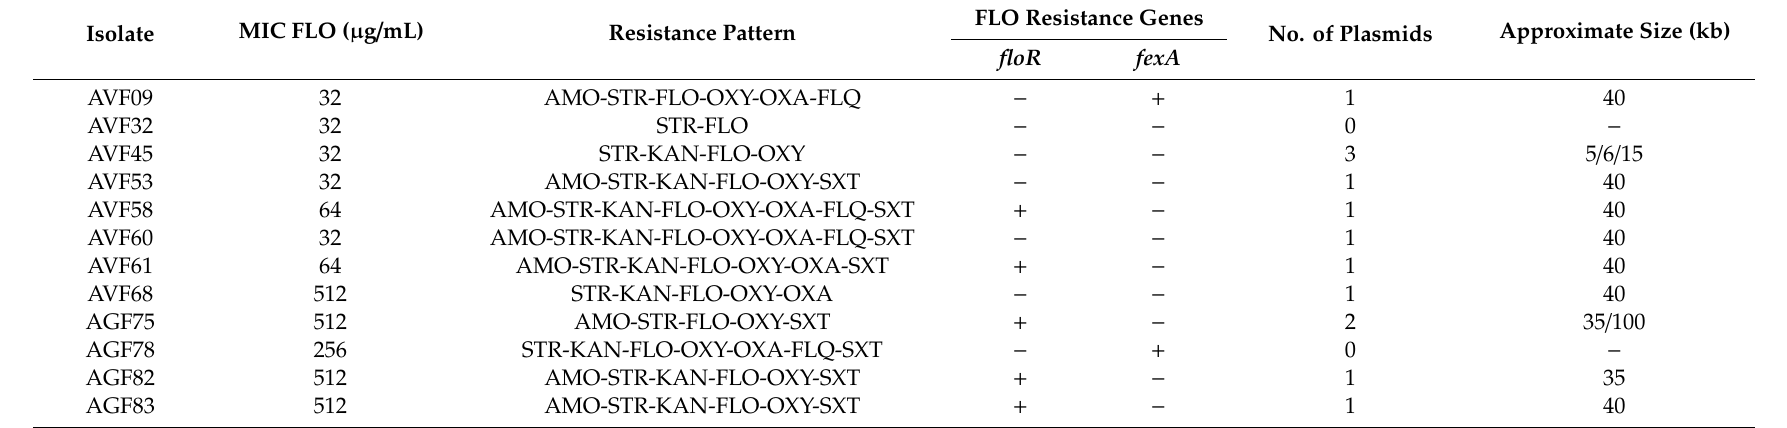
Table 5. Minimum inhibitory concentrations (MICs) of florfenicol (FLO), antimicrobial resistance patterns, florfenicol-resistance-encoding genes, and plasmid content of resistant isolates recovered from Artemia